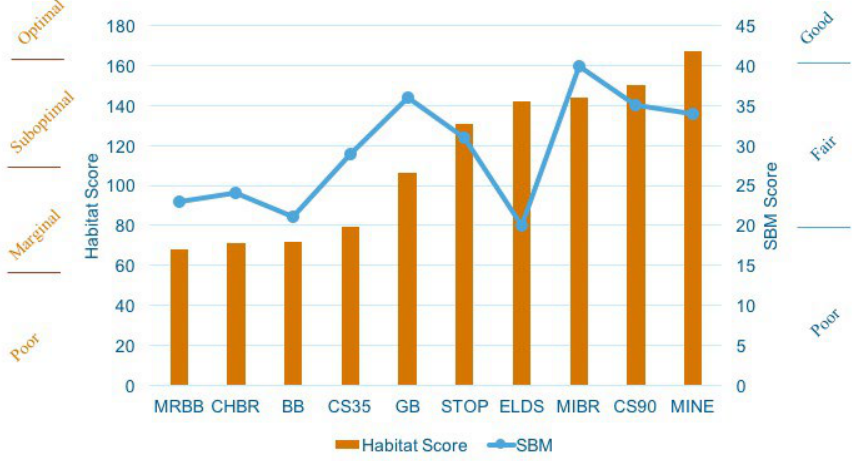
Figure 2. Biplot of USEPA Rapid Bioassessment Habitat Assessment for Low Gradient Streams (Habitat Score) and the USEPA Streamside Biosurvey: Macroinvertebrates (SBM) scores at the ten 100-meter reach sample stations throughout the Charles River watershed sampled in 2011. Table 2. Physical–chemical properties of 10 sample stations within the Charles River watershed sampled in